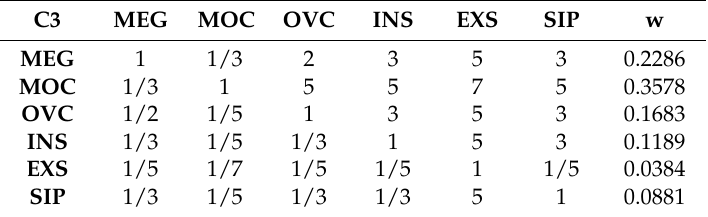
Table 6. Comparison of the six alternatives with regards to costs